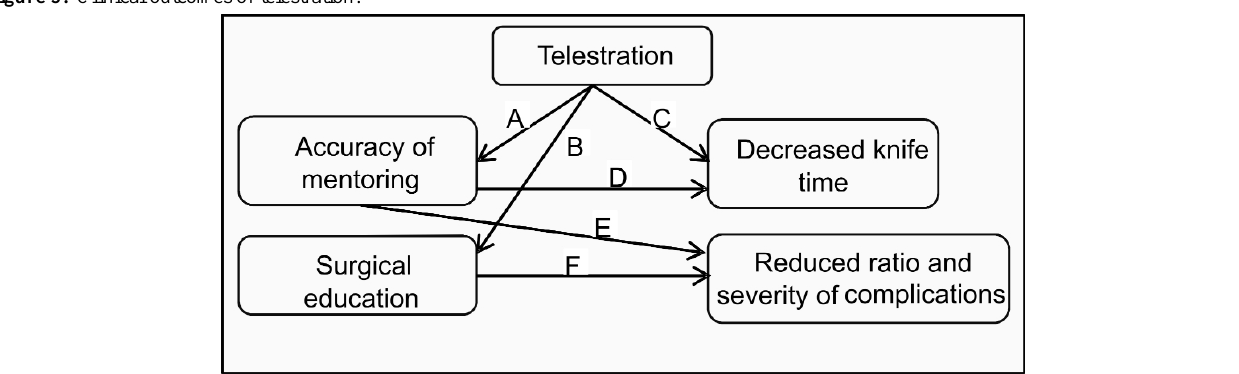
Figure 5. Clinical outcomes of